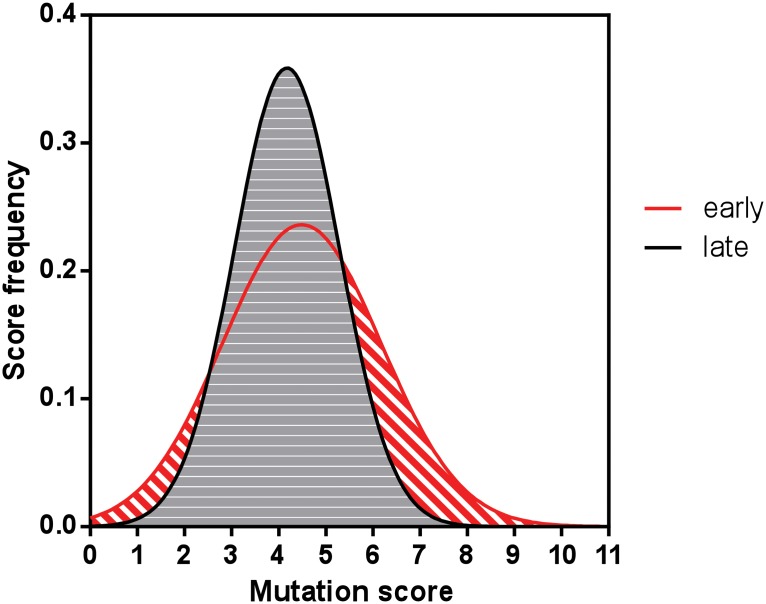
Distribution of total mutation scores according to age of disease onset.The data are presented as the fitted Gaussian curve and the area under the curve. Distribution analysis, normality test, and data fit were performed with GraphPad Prism software. Early and late ages of disease onset are according to [25] and the references therein. Early age of onset is considered less than 6 years of age. Late age of onset is considered greater than 6 years (see text for more information).